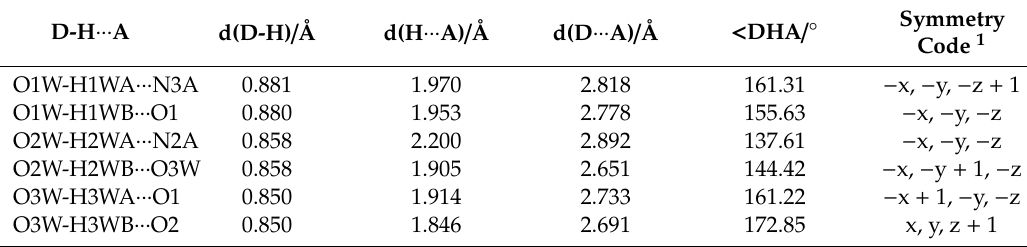
Table 3. Geometrical parameters for the hydrogen bonds in complex 1 .